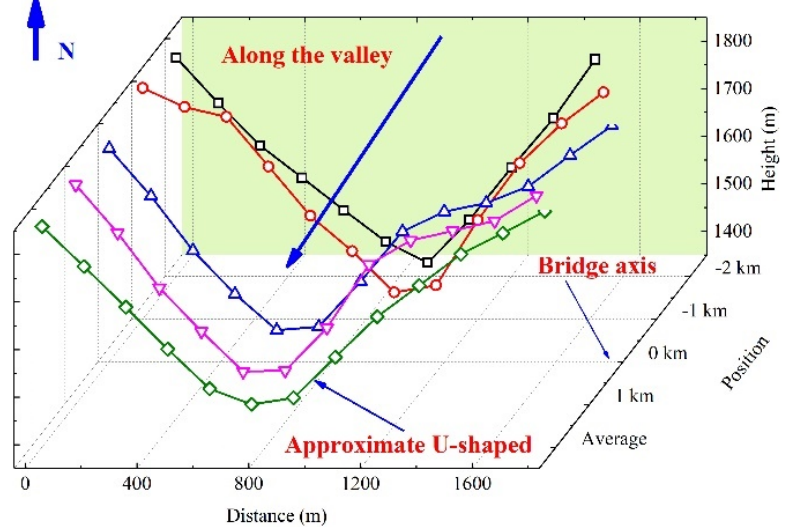
Figure 3. Terrain contour line.